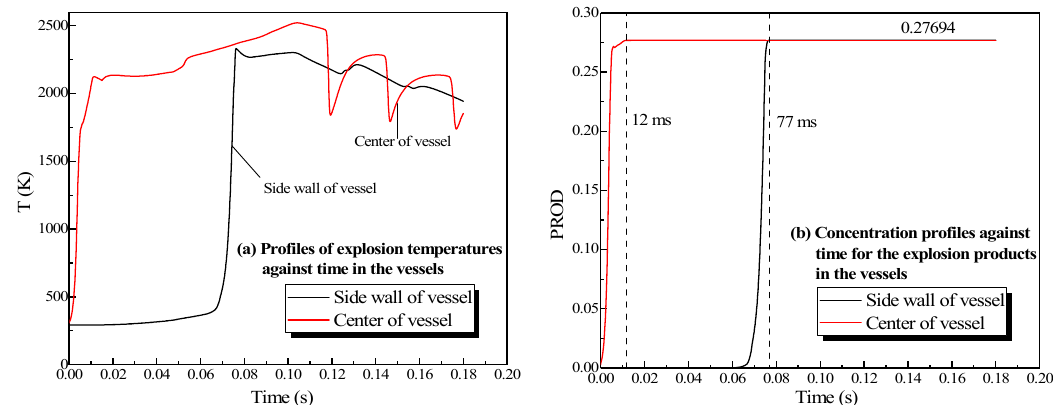
Figure 6. Contours of the natural gas explosion parameters (pressure, temperature, and concentration of products) in the single vessel with a pipe connected to it; ( a ) distribution of pressure. ( b ) distribution of temperature; ( c ) distribution of the concentration of products.